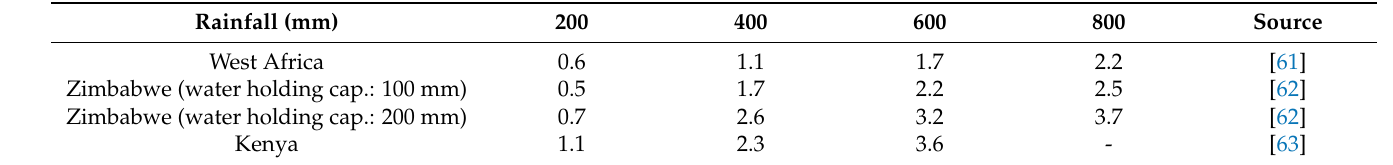
Table 5. Estimation of total forage production (t DM ha-1) under various rainfall regimes